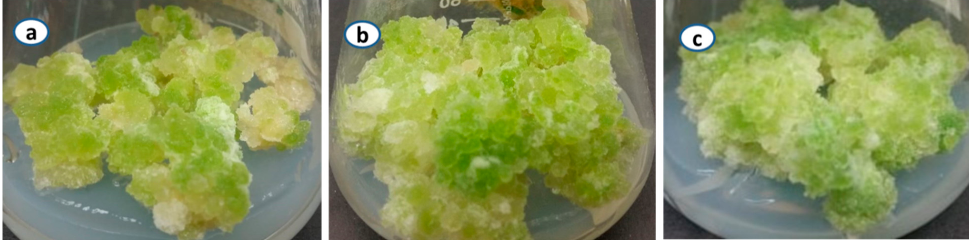
Figure 1. Calllus morphology of Lepidium sativum ( a ) Control ( b ) UV-C (60 min) ( c ) Melatonin (20 µ M).